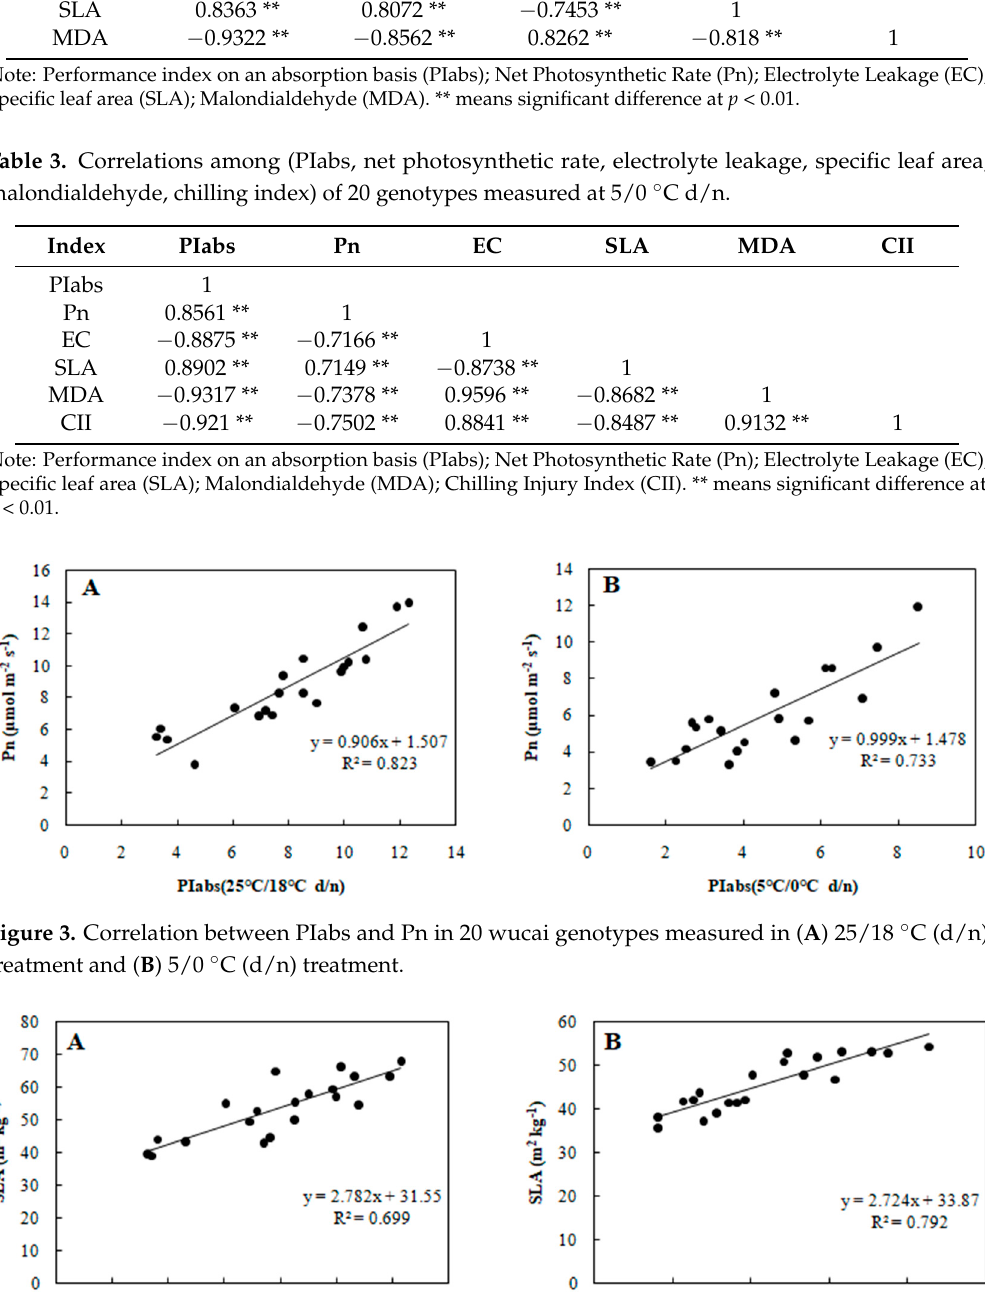
Table 2. Correlations among (PIabs, net photosynthetic rate, electrolyte leakage, specific leaf area, malondialdehyde) of 20 genotypes measured at 25/18 °C d/n.